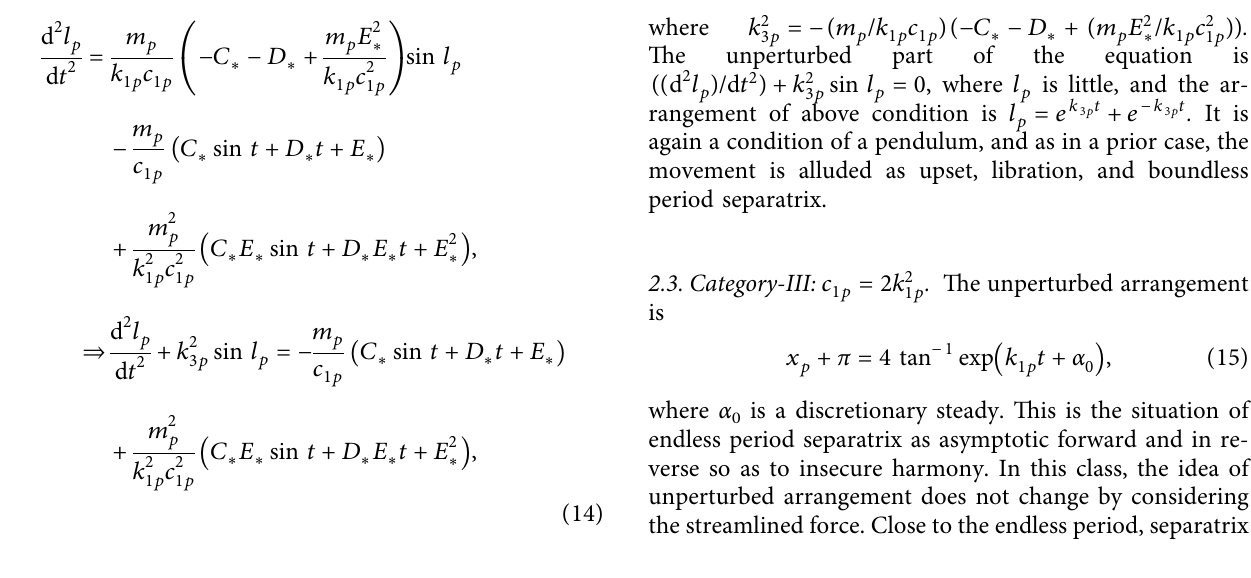
Figure 6: For n � 0 . 00001 , ε � 0 . 0000000000000000000000005 ,A E � 200 . 1022 , and e � 0 . 001. (a) Poincare map, (b) Poincare surface of section, (c) Lyapunov exponent, and (d) time ∗